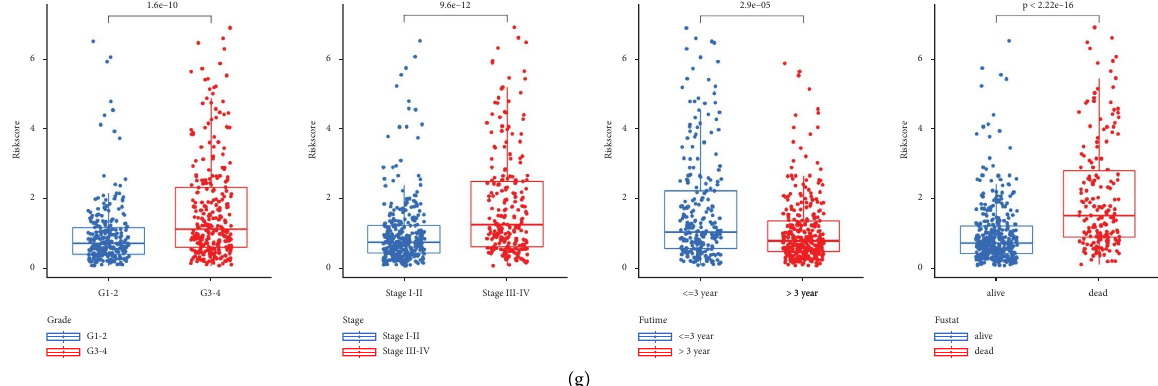
Figure 6: Construction and validation of the prognostic risk model based on DRGs: (a) nature of the network topology constructed with unique power values and the relationship between power values and average connectivity, (b) discrete modules of obtained through DRGs clustering, (c) module diagram of the correlation between clinicopathological characteristics and identifed modules, (d) coefcient profle plot of the log (lambda) sequence of the LASSO model, (e–f) heatmaps of the expression levels of prognostic genes, curves of the risk score, and scatter plots of survival status in the training and validation cohort, and (g) box plots of the correlation between clinical variables and risk